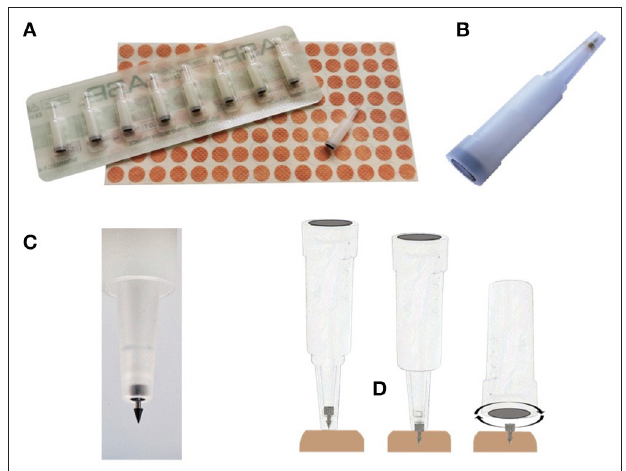
FIGURE 1 | The semipermanent needles (SPNs). (A) SPN packaging. (B) Close-up of a SPN inside its sterile blister. (C) Close-up of a SPN ready to be inserted in the skin of the outer ear. (D) The three-step procedure for SPN insertion: (1) the blister is placed on the disinfected skin point, (2) a pressure exerted on the blister delivers the SPN inside the skin, and (3) the SPN is once again sinked using the bottom end of the blister (images from Sedatelec R , Irigny,